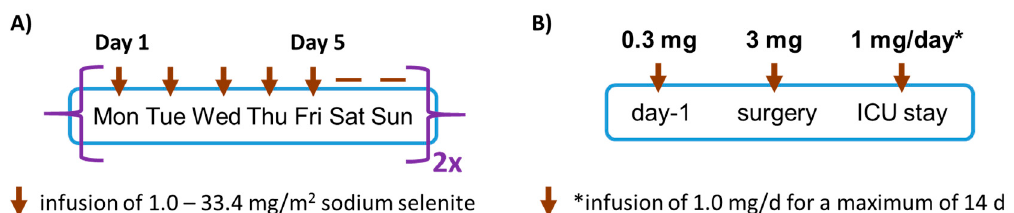
Figure 1. Clinical studies involving intravenous selenite treatment. ( A ) In the Selenite in the Treatment of Patients with Carcinoma (SECAR) phase 1 clinical study, cancer patients received an infusion of different dosages of sodium selenite once per weekday, with a break at the weekend, for two or four cycles. Plasma samples were taken before infusion and at day 5. ( B ) In the SOS-LVAD study, patients received placebo or 300 µg of selenite the day before surgery, placebo or 3 mg of selenite after induction of anesthesia before surgery, and placebo or 1 mg of selenite (*) directly after completion of surgery and daily during the stay on the intensive care unit (ICU) for a maximum of 14 days. Plasma samples were collected at each time point prior to infusion with placebo or selenite.